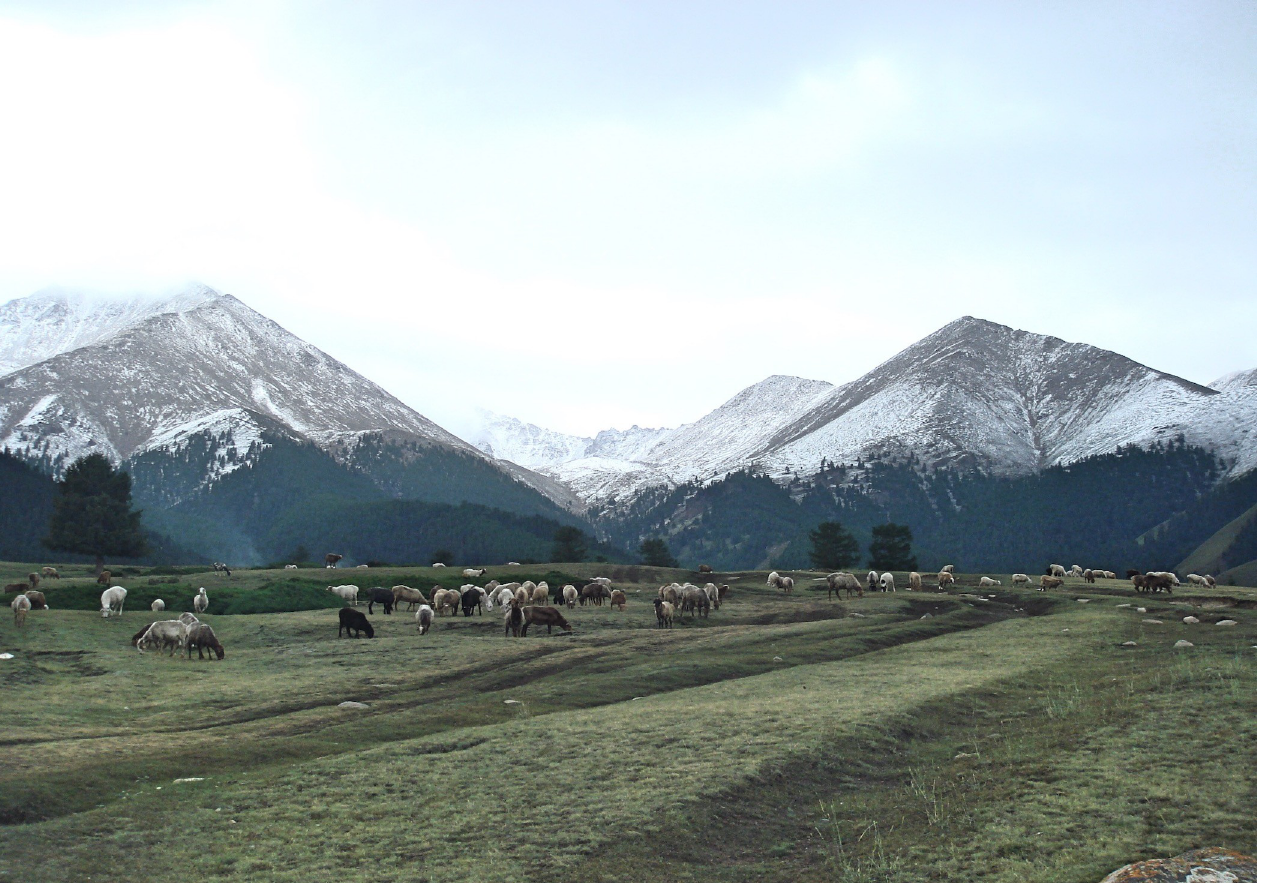
Fig 2. Photo showing modern natural landscape surrounding the site of